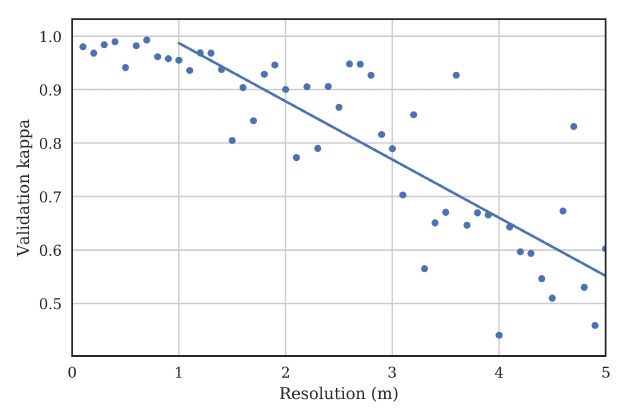
Figure 6. Classification validation accuracy kappa for identifying the water, land and weed classes as a function of the image